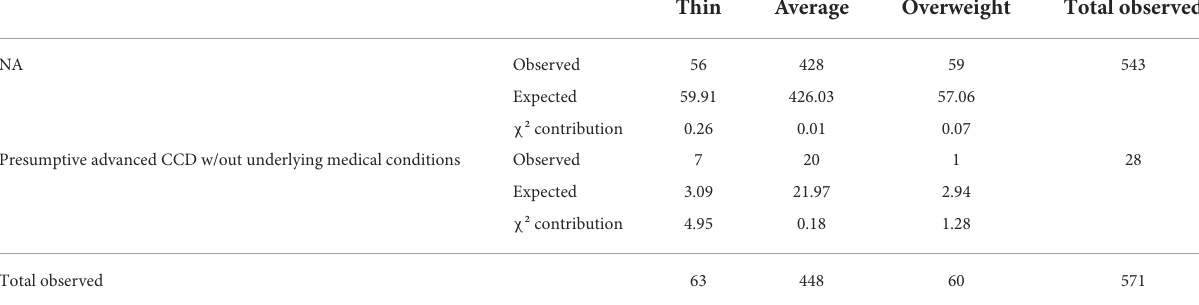
TABLE 6 Evaluation of the association of body condition score between NA and presumptive Advanced CCD groups without underlying medical conditions using the chi-square test [degrees of freedom: 2; chi-square ( χ ² ): 6.7394 p -value: